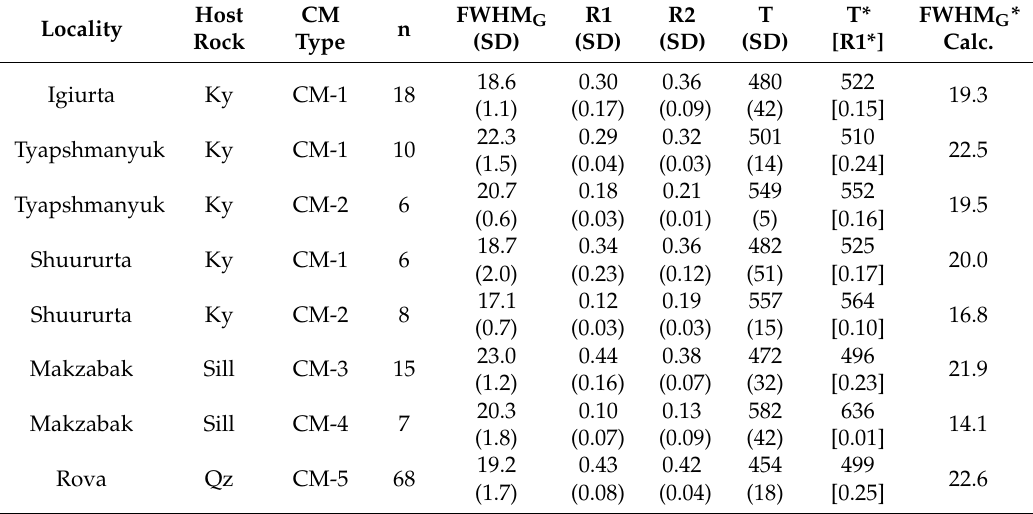
Summary of Raman spectra of carbonaceous material (RSCM) peak temperature determinations from CM-bearing rocks of the Keivy